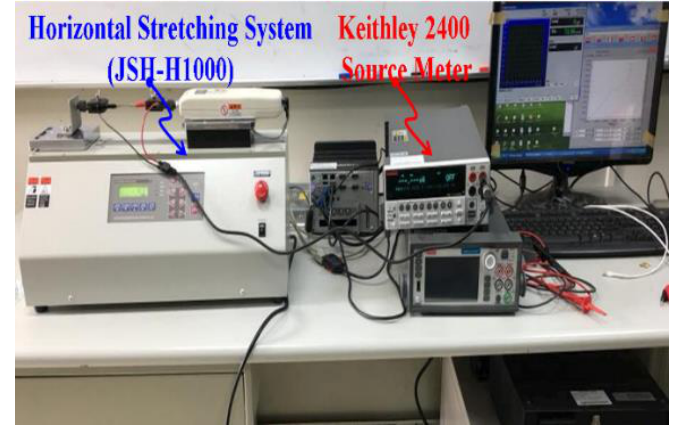
Figure 3. A real setup picture of electrical and mechanical stretching measurements.